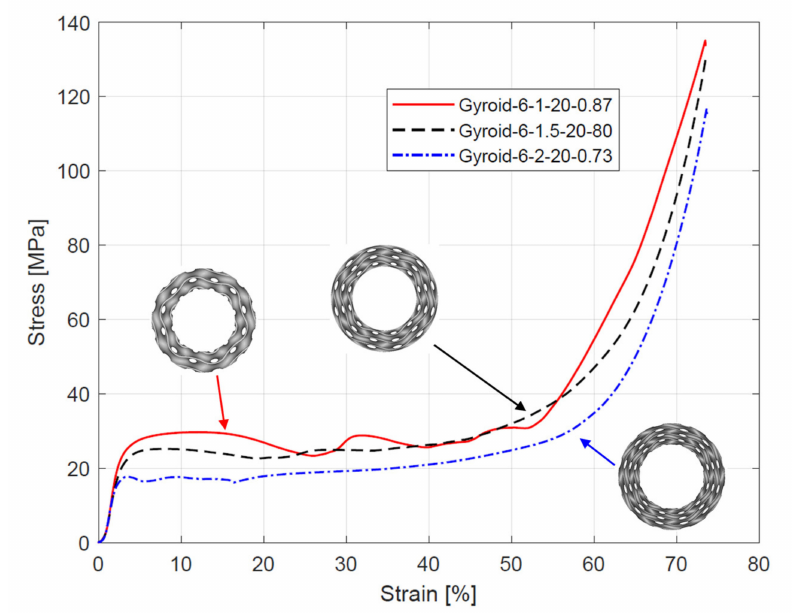
Figure 9. Stress–strain curves from compressive testing of cylindrically mapped gyroid structures with 6 unit cells in a circumferential direction.